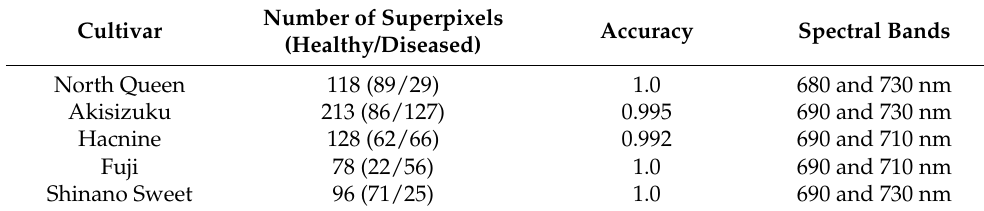
Table 2. Cross-validation results of the five cultivars.